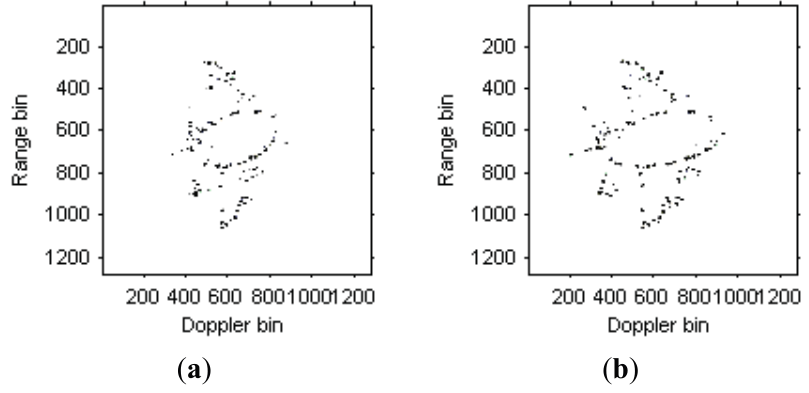
Figure 9. Radar image based on Chirplet decomposition algorithm. ( a ) Radar image at time t = 0.17 s; ( b ) Radar image at time t = 0.22